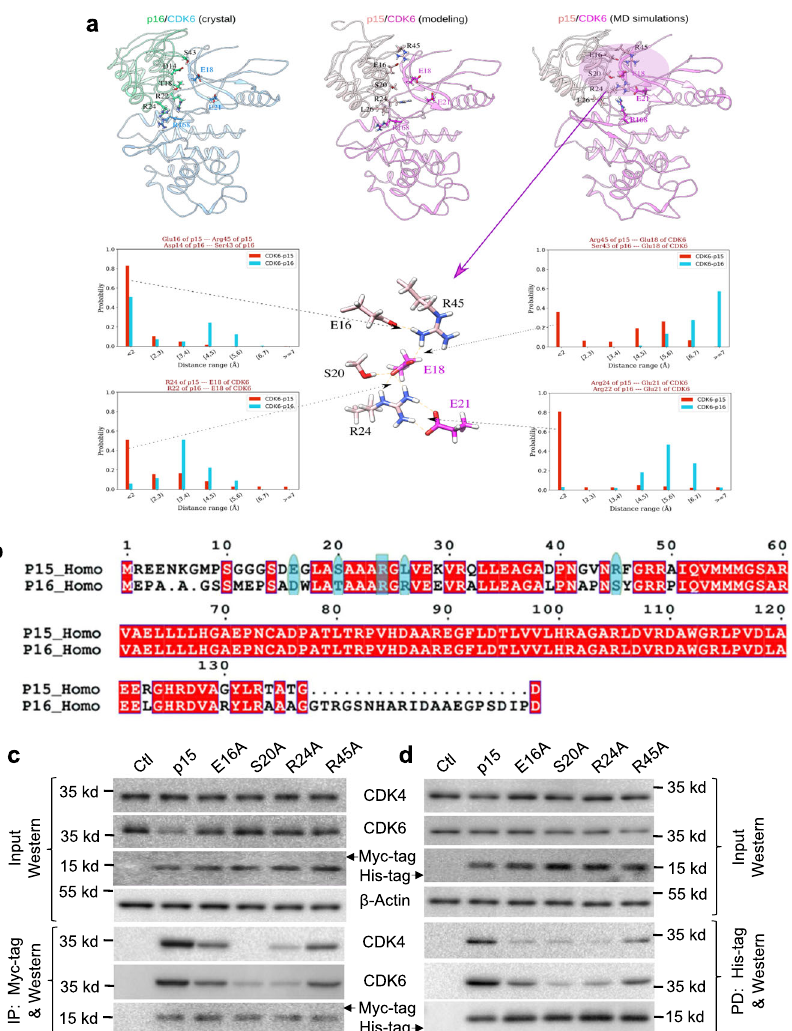
Fig. 6 Structural modeling and experimental veri fi cation of amino acids in p15 that are critical for binding to CDK6. a Homology modeling of p15 binding to CDK6 (top middle panel) based on the available crystal structure of p16/CDK6 complex (top left panel). Molecular dynamics simulations revealed that several N-terminal residues of p15 may form salt-bridges and H bonds with CDK6 (magenta circle of top right panel with enlarged simulation in the bottom middle panel), while the p16/CDK6 complex lacks such interactions (bottom left and right panels show the minimum distance distributions of identi fi ed key interactions for p15/CDK6, compared with p16/CDK6, in MD simulations). Speci fi cally, Arg24 of p15 may be a hotspot residue in the p15/CDK6 interactions, and Glu16 of p15 may form a salt bridge with Arg45, which will be stabilized in the position and form salt bridge with CDK6. b Sequence alignment of p15 and p16 using Clustal W 1.83 (ref. 68 ). c , d Site-directed mutagenesis of the putative CDK6-binding residues in the N terminus p15 to alanine followed by inducible expression of Myc-tagged proteins in UMUC and immunoprecipitation ( c ) or by pull-down using E. coli -produced, histidine- tagged mutant proteins in the presence of total proteins of UMUC cells ( d ). Note that the E16A, S20A, R24A, and R45A mutants had signi fi cantly reduced binding to both CDK4 and CDK6, although the mutational effects differed among the different mutants and binding detection methods (see “ Results ” for details). Experiments in c and d were repeated three times with similar results. Source data are provided as a Source Data fi